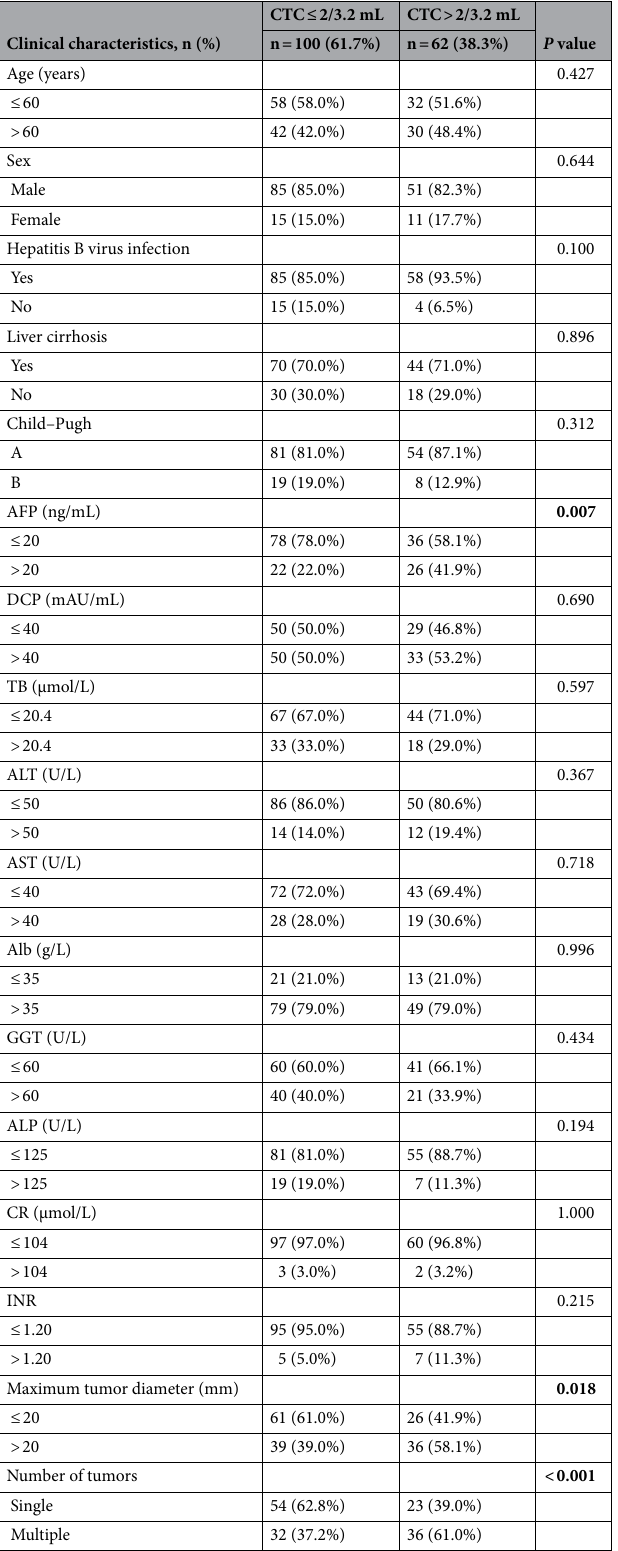
Table 2. Relationship between CTCs and clinical characteristics. CTC, Circulating tumor cell; AFP, Alpha- fetoprotein; DCP, Des-γ-carboxy prothrombin; TB, Total bilirubin; ALT, Alanine aminotransferase; AST, Aspartate aminotransferase; Alb, Albumin; GGT, Gamma-glutamyltransferase; ALP, Alkaline phosphatase; CR, Creatinine; INR, International normalized